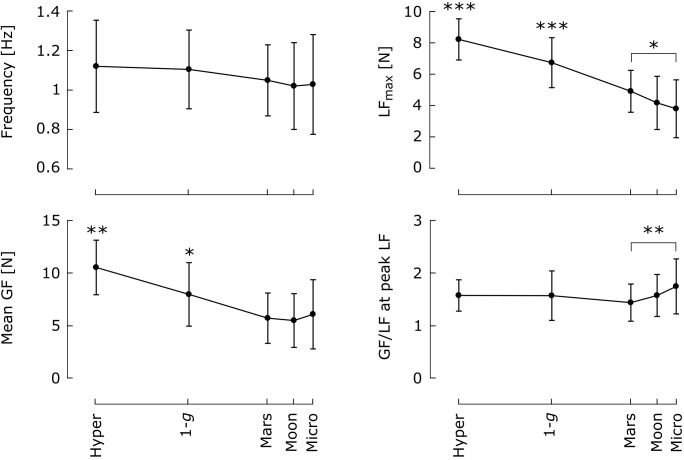
Mean and 95% confidence interval of the mean (N = 8) of frequency, maximum LF, mean GF and GF/LF ratio at the time of peak LF as a function of gravity condition. Means that differ significantly across conditions are marked with an asterisk (∗p < 0.05; ∗∗p < 0.01; ∗∗∗p < 0.001). Blocks within the same condition and subject were pooled. Only the last six blocks were selected in the Mars condition, and the first two blocks performed in 1 g on board the aircraft were excluded from the analysis of movement frequency.